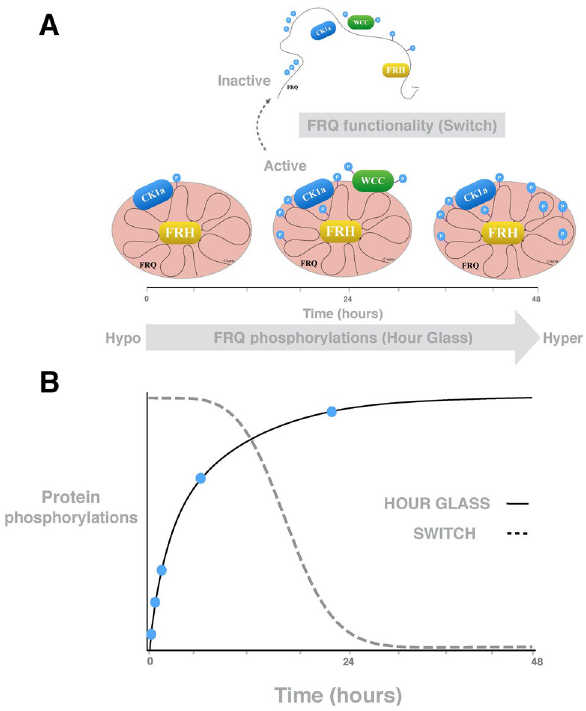
Figure 1. Phosphorylation hourglass and activity switch of phosphoproteins: (A) As an example, the FRQ protein is stabilized by FRH and undergoes multiple phosphorylations by CK1a. FFC complex interacts with WCC. A phosphoswitch governs the activity status of the complex. (B) The solid line represents the simulated phosphorylations in Fig. 7 and suggests a slow and saturated phosphorylation. The dashed line represents the simulated switch induced by hyperphosphorylated protein (compare Fig.